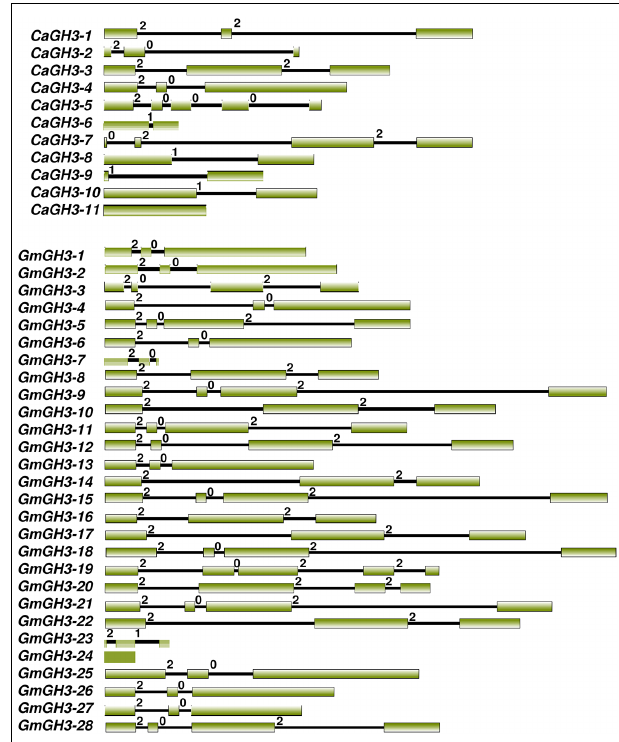
FIGURE 1 | Exon-intron organization of chickpea and soybean GH3 genes. Boxes and lines represent exons and introns, respectively.The numbers 0, 1, and 2 represent phase 0, 1, and 2 introns,